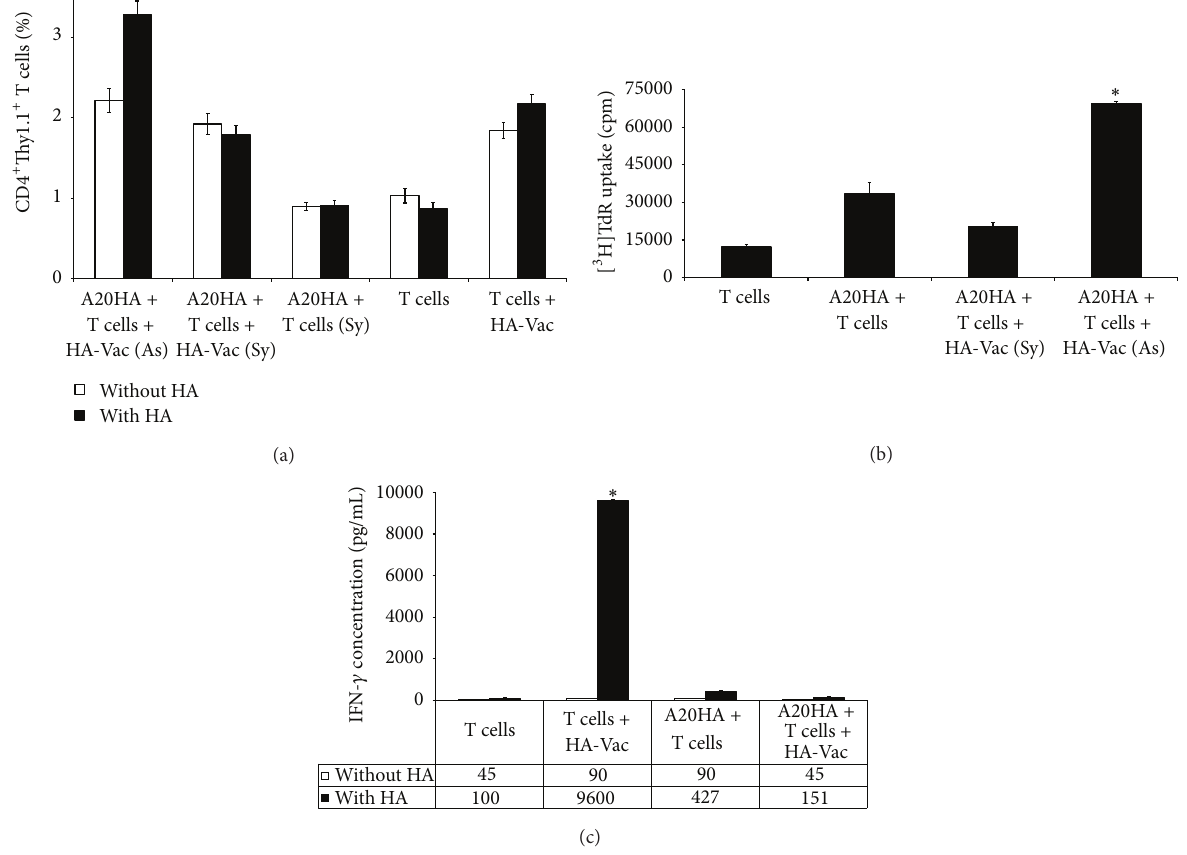
Figure 7: HA-specific CD4 + T cells from spleen of symptomatic mice versus asymptomatic are refractory to restimulation with HA peptide in vitro after HA vaccination in vivo . (a) Percent of HA-specific CD4 + Thy-1.1 + T cells measured by FASC, (b) proliferative response measured by [ 3 H]TdR incorporation, and (c) concentration of IFN- 𝛾 in the supernatants measured by ELISA on day 18 after the adoptive transfer. HA-specific CD4 + Thy1.1 + T cells were injected i.v. into A20HA brain tumor-bearing mice on day 5 after i.c. tumor inoculation. Virus HA-Vac was delivered i.p. on day 15 after the adoptive transfer. Individual spleens from asymptomatic (As) and symptomatic (Sy) mice were isolated 3 days later, and cell cultures were analyzed after 72 h incubation with or without HA peptide in triplicate wells. A20HA + T cells + HA-Vac, mice that received A20HA tumor cells, HA-specific CD4 + Thy1.1 + T cells, and virus HA-Vac; A20HA + T cells, mice that received A20HA tumor cells and HA-specific CD4 + Thy1.1 + T cells; T cells + HA-Vac, mice that received HA-specific CD4 + Thy1.1 + T cells and virus HA-Vac; T cells, mice that received only HA-specific CD4 + Thy1.1 + T cells. Numbers under axis in (c) show IFN- 𝛾 concentrations. Data are represented as the mean ± SD, 𝑛 = 3 . ∗ 𝑃 < 0.05